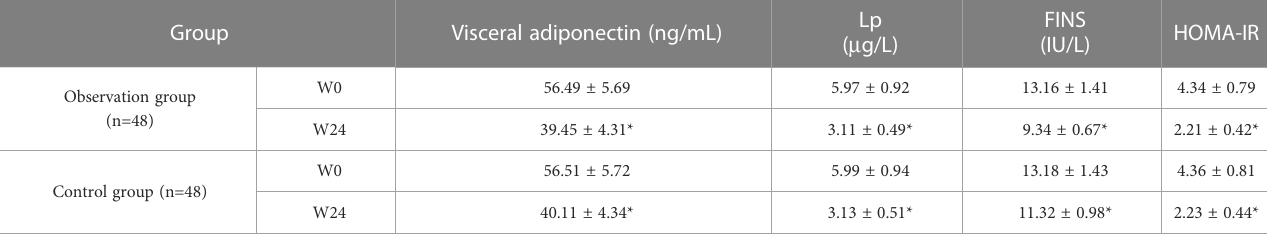
TABLE 2 Comparison of biochemical indices and Homa-IR index between control and observation groups .